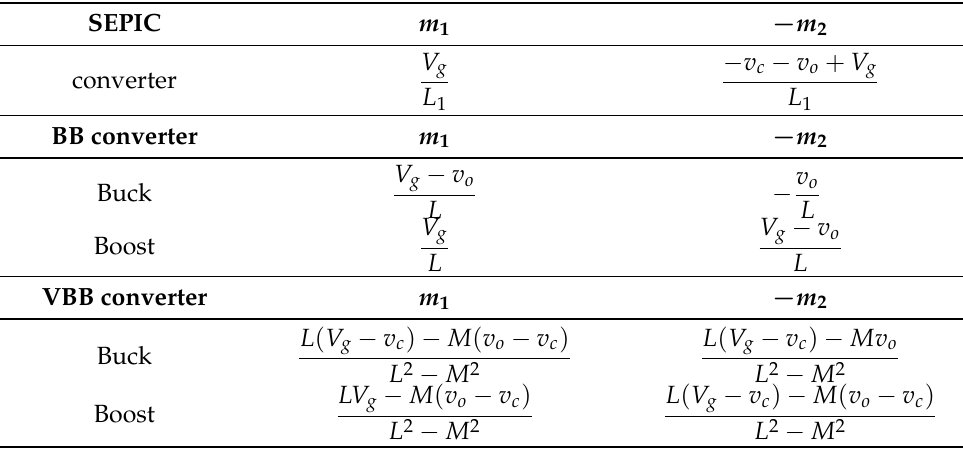
Table 3. Slopes of i g current